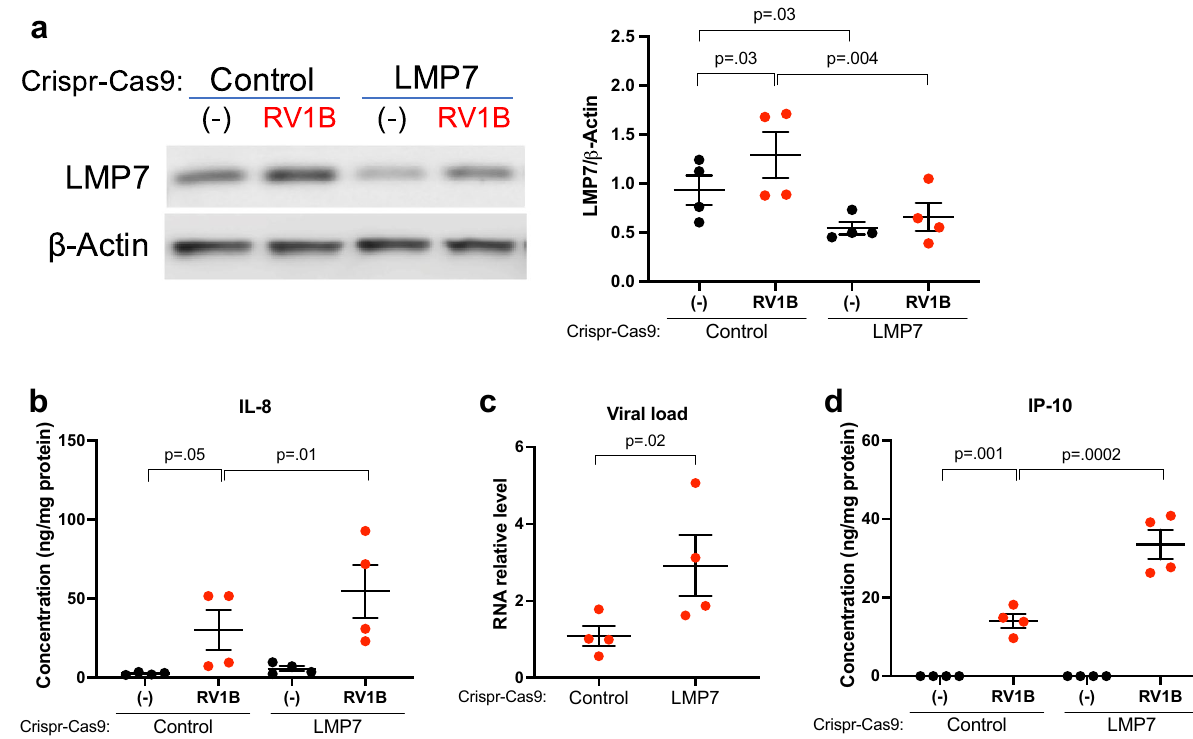
Figure 2. LMP7 inhibits pro-inflammatory responses and reduces viral load in RV-infected human tracheobronchial epithelial (HTBE) cells . HTBE cells (n = 4 independent experiments) were transduced with lentivirus containing the LMP7 sgRNA or scramble control (Control) plasmid construct and were differentiated at air–liquid interface (ALI) culture. Cells were infected with 10 5 PFU/well RV1B or 0.1% BSA-PBS (−) at day 21 of ALI. ( A ) Representative western blot image and densitometry of LMP7 protein. ( B ) IL-8 levels measured in the basolateral supernatant by ELISA were normalized to total protein in the cell lysate. ( C )